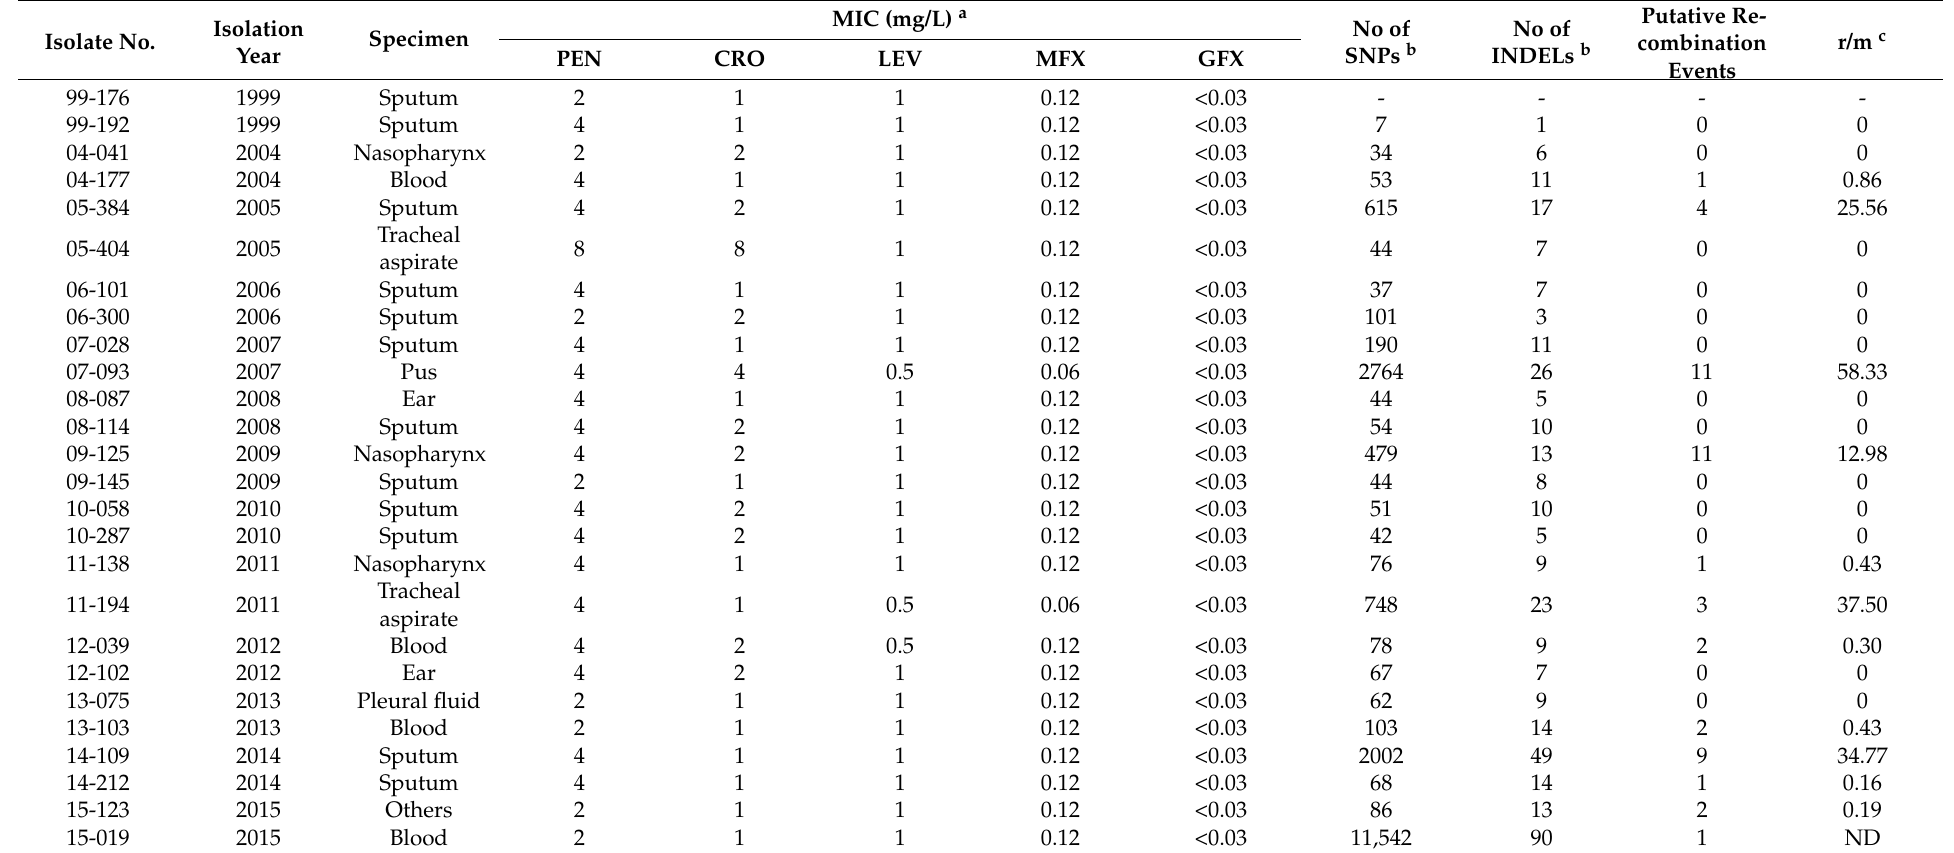
Table 1. Characteristics of the S. pneumoniae isolates analyzed in this